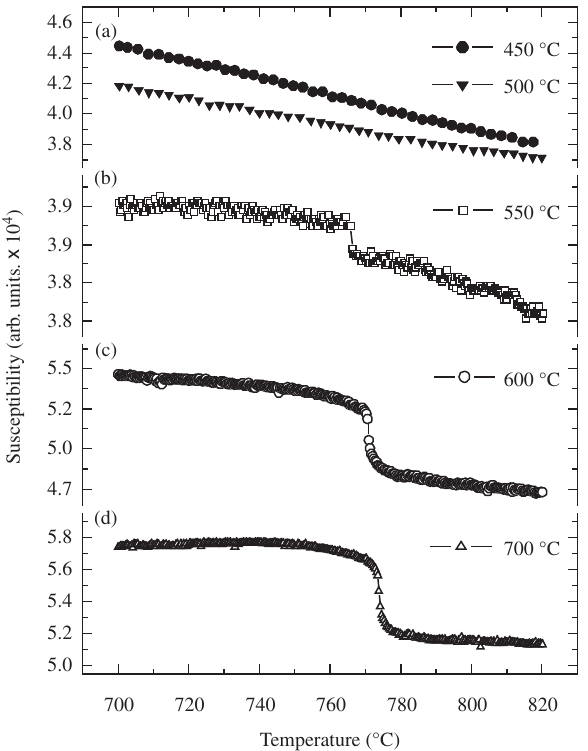
Figure 4. AC susceptibility of the Fe